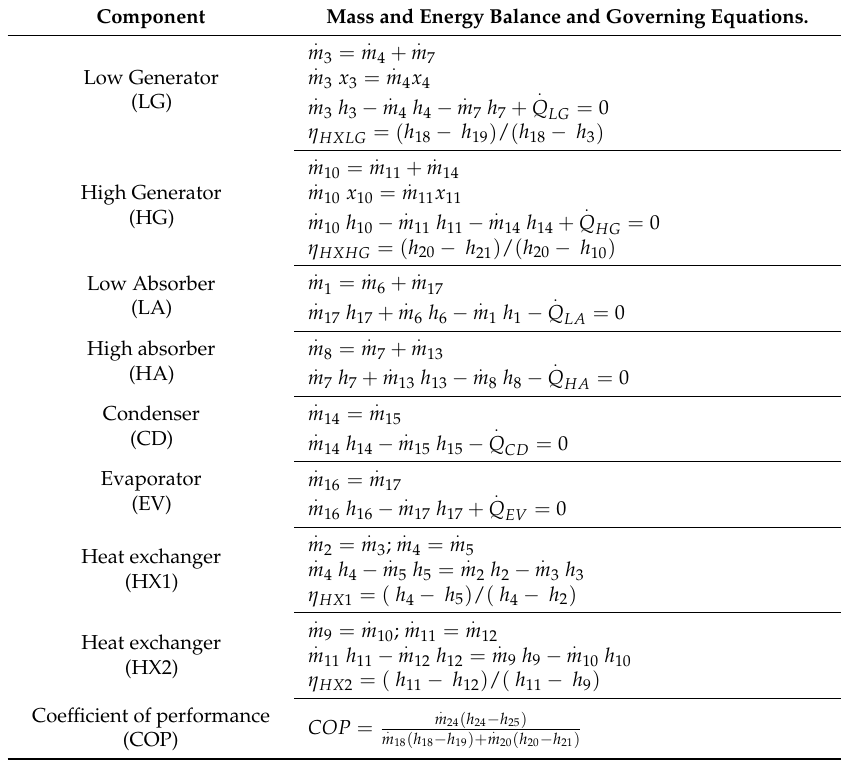
Table 2. Mass and energy balance and governing equations for each component. Component Mass and Energy Balance and Governing